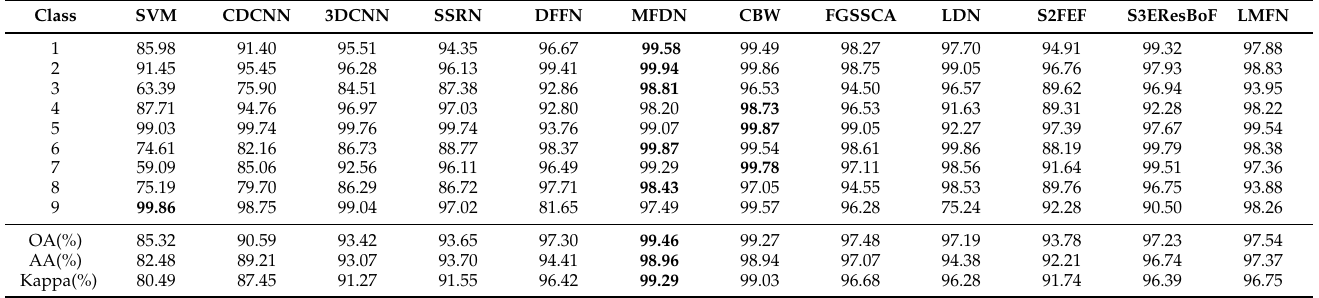
Table 7. Performance comparison with state-of-the-art methods, in terms of classification accuracy, for the UP data set. The best results are highlighted in bold font.